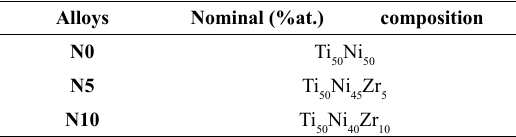
Table 1. Nominal composition of Ti-Ni-Zr alloys in atomic weight Alloys Nominal